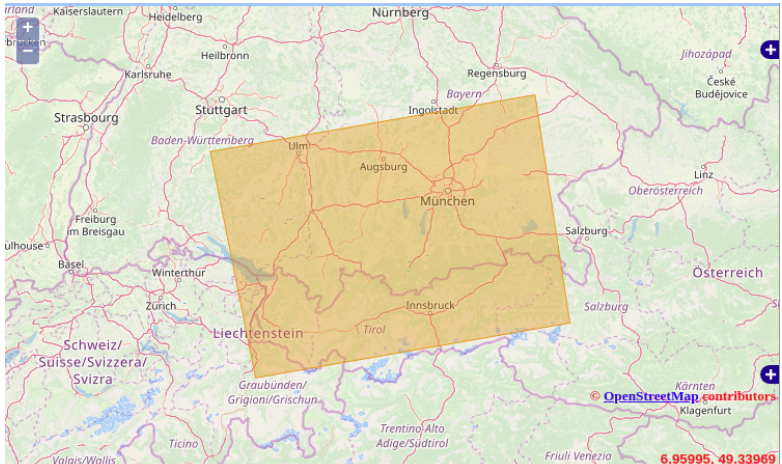
Figure 7. Sentinel 1 Interferometric Wide-Swath TOPS Mode imaged area: the yellow rectangle represents the investigated zone located in Southern